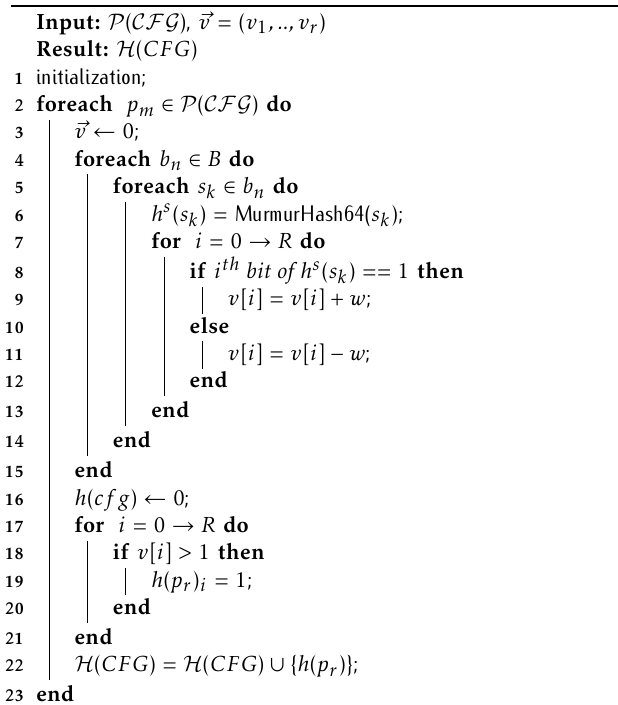
Algorithm 2.3: Control Flow Graph